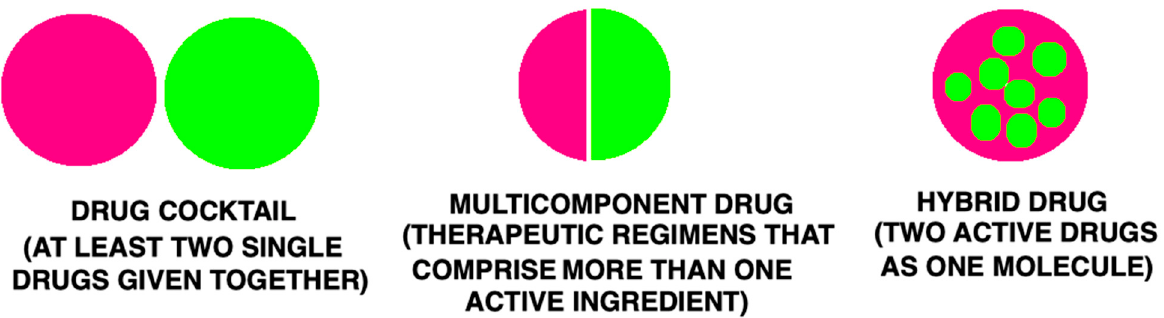
Figure 1. Types of multitarget therapies.